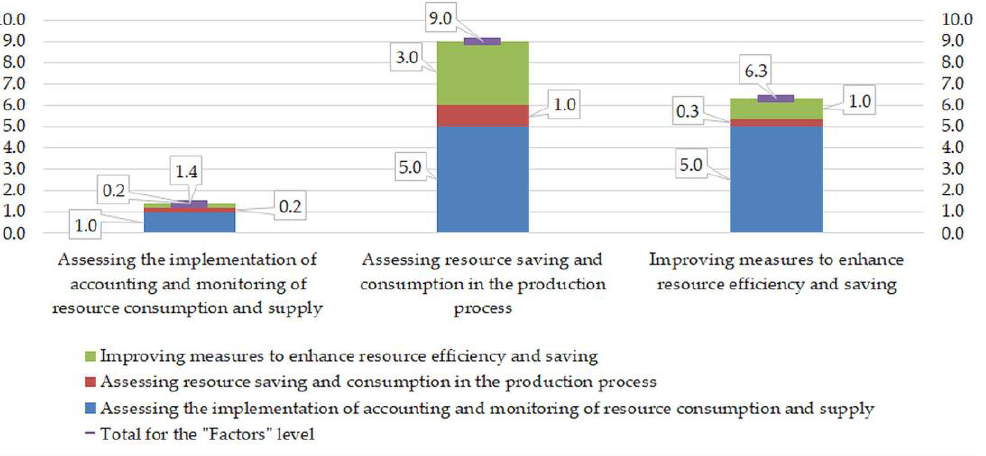
Figure 3. Degree of influence on consumption and saving of company resources at the “Factors” level.